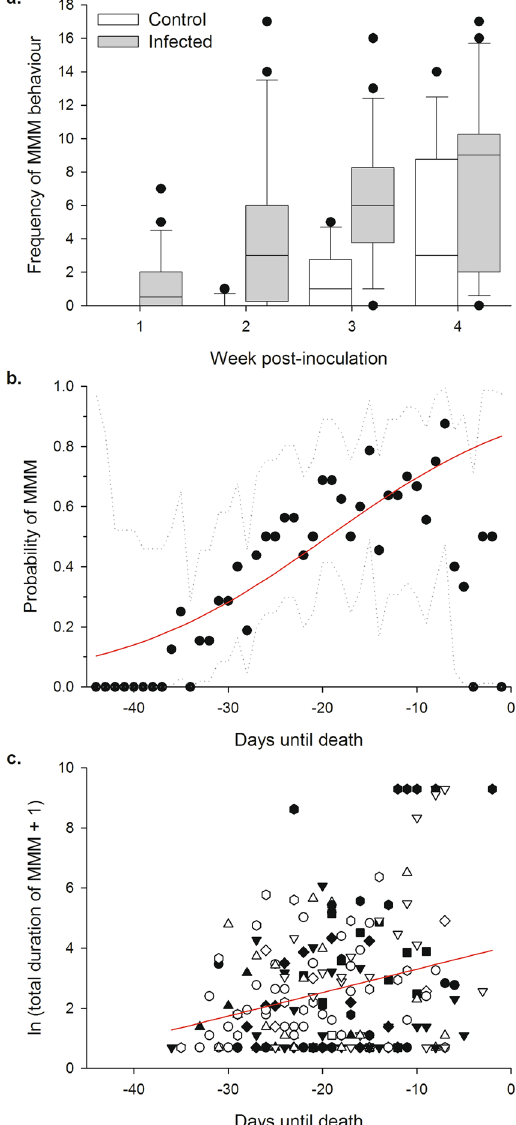
Figure 1. Male-male mounting behaviour in fungus-infected and control locusts. ( a ) Frequency of MMM behaviour observed in 24 fungus-infected and 12 control locusts over a 28-day period following inoculation. MMM behaviour frequencies were observed for 3 hours each day, and are summed over each week post- inoculation. Boxes denote the median, 25 th and 75 th percentile values, whiskers the 5 th and 95 th percentile values, and circles the more extreme observations. Note that two fungus-infected locusts died during the experiment, resulting in a sample size of 22 for that treatment in weeks three and four. ( b ) Probability of fungus-infected locusts mounting another male according to the time remaining until their death, for the 16 locusts from panel ( a ) that died during days 29–45 post inoculation. Points show the proportion of locusts performing at least one instance of MMM behaviour on a particular day before death. Because the sample size of locusts that were observed at a particular day before death varied according to their actual time of death, the resulting 95% binomial confidence intervals are plotted as dotted lines. The red line represents the fitted probability of performing MMM behaviour according to binary logistic GEE analysis (see text). ( c ) Natural log (x + 1) transformed duration of total time spent mounting other males for each locust that performed MMM behaviour on a particular day in panel ( b ), according to the time remaining until its death. Observations from the same individual have the same symbol and fill. Red line indicates the fitted relationship according to GEE analysis (see